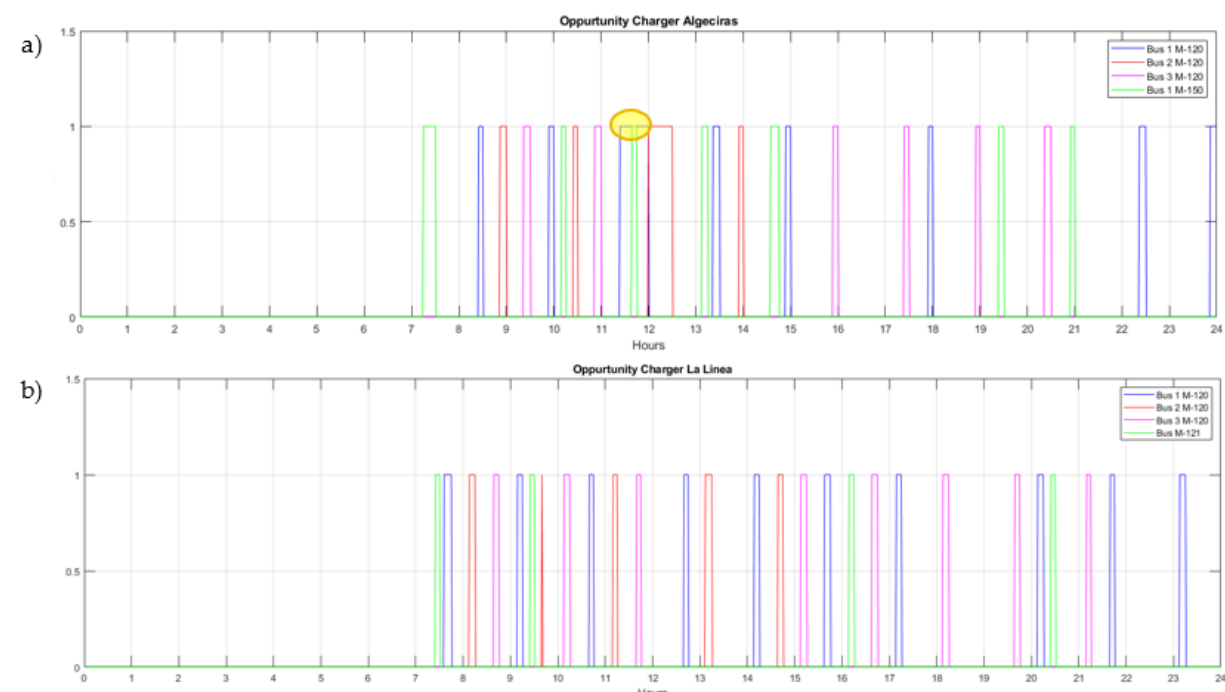
Figure 22. Opp Chargers occupation profiles installed in ( a ) Algeciras and ( b ) La Linea.